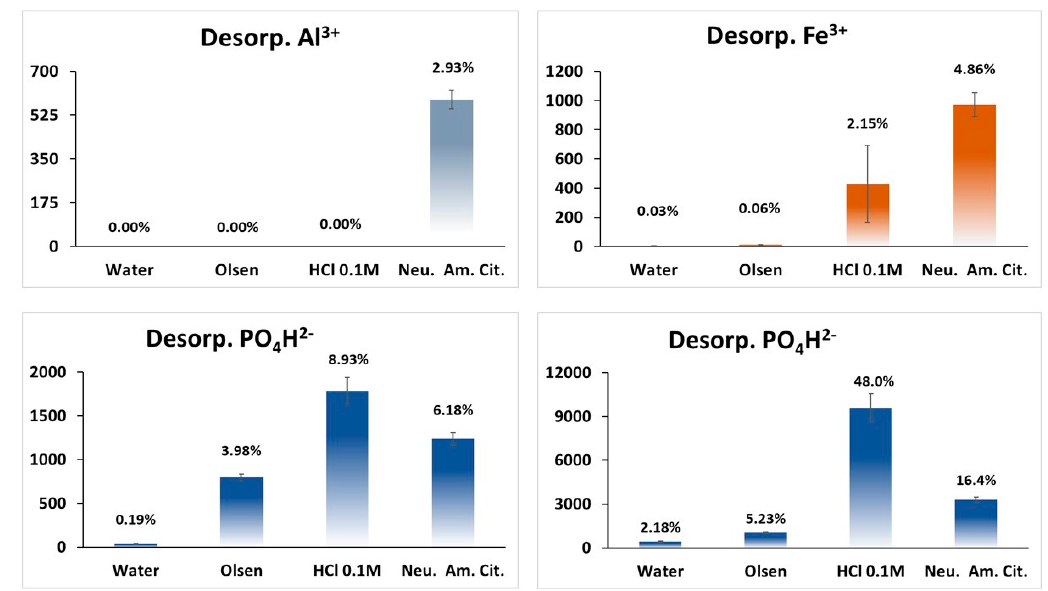
Figure 3. Desorption data for Pi-Al-biochar and Pi-Fe-biochar complexes. Al, Fe, and Pi percentages were relative to the 1000 mg L − 1 of each element added.